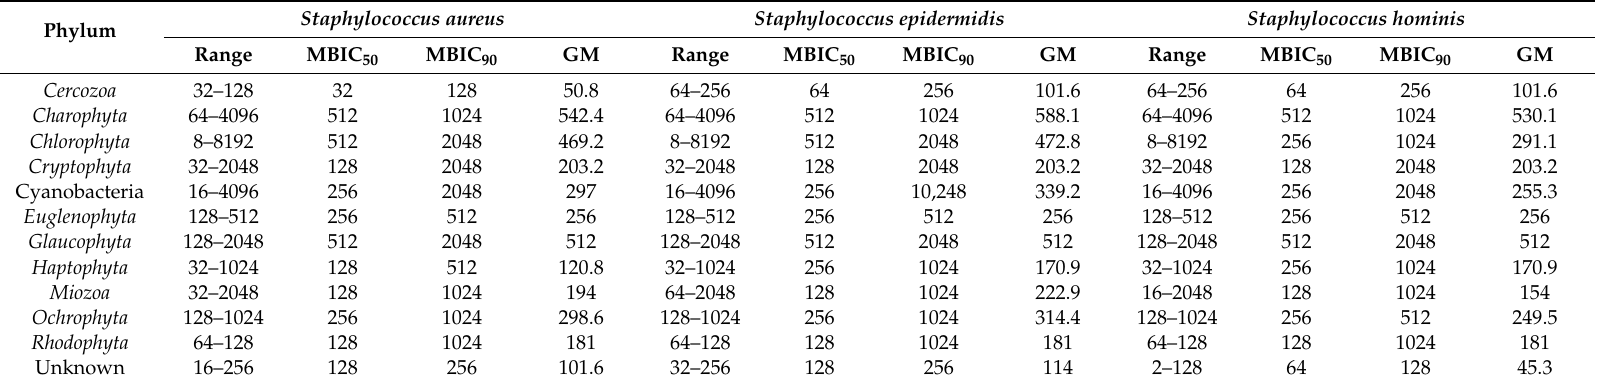
Table 2. Antibiofilm activity against Gram-positive bacteria of marine natural products. Range: range of concentrations tested; MBIC 50 : lowest concentration of the test compound that resulted in ≥ 50% inhibition of biofilm formation; MBIC 90 : lowest concentration of the test compound that resulted in ≥ 90% inhibition of biofilm formation; GM: geometric mean. MBICs are reported in µ g /